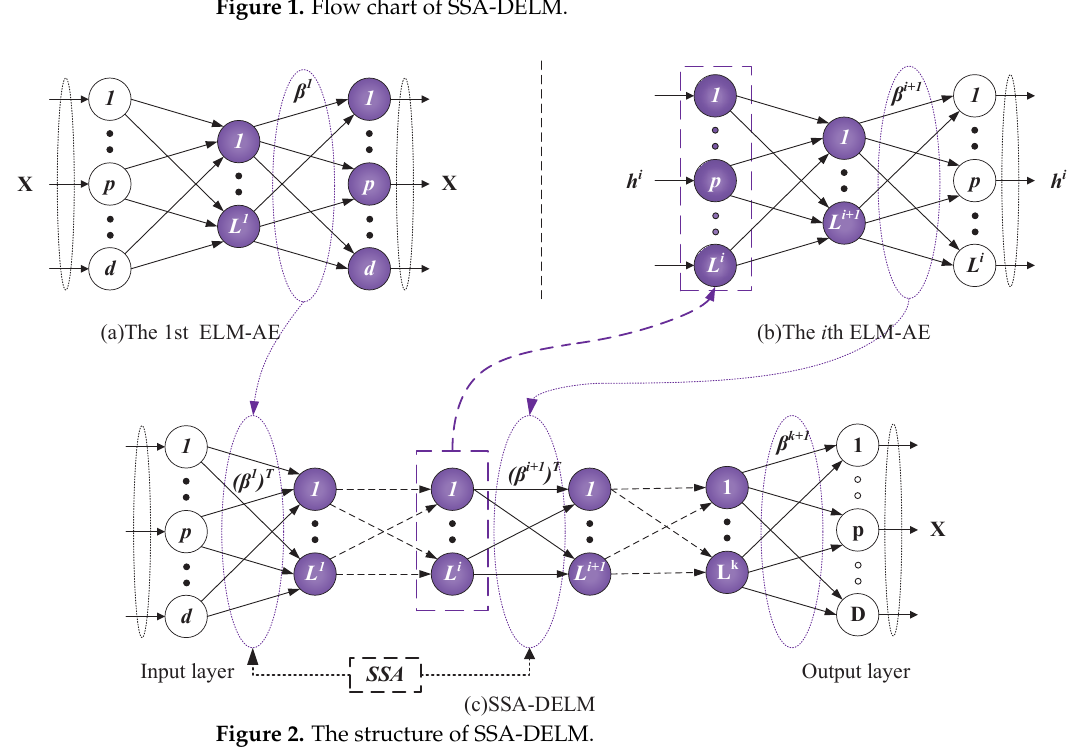
Figure 2. The structure of